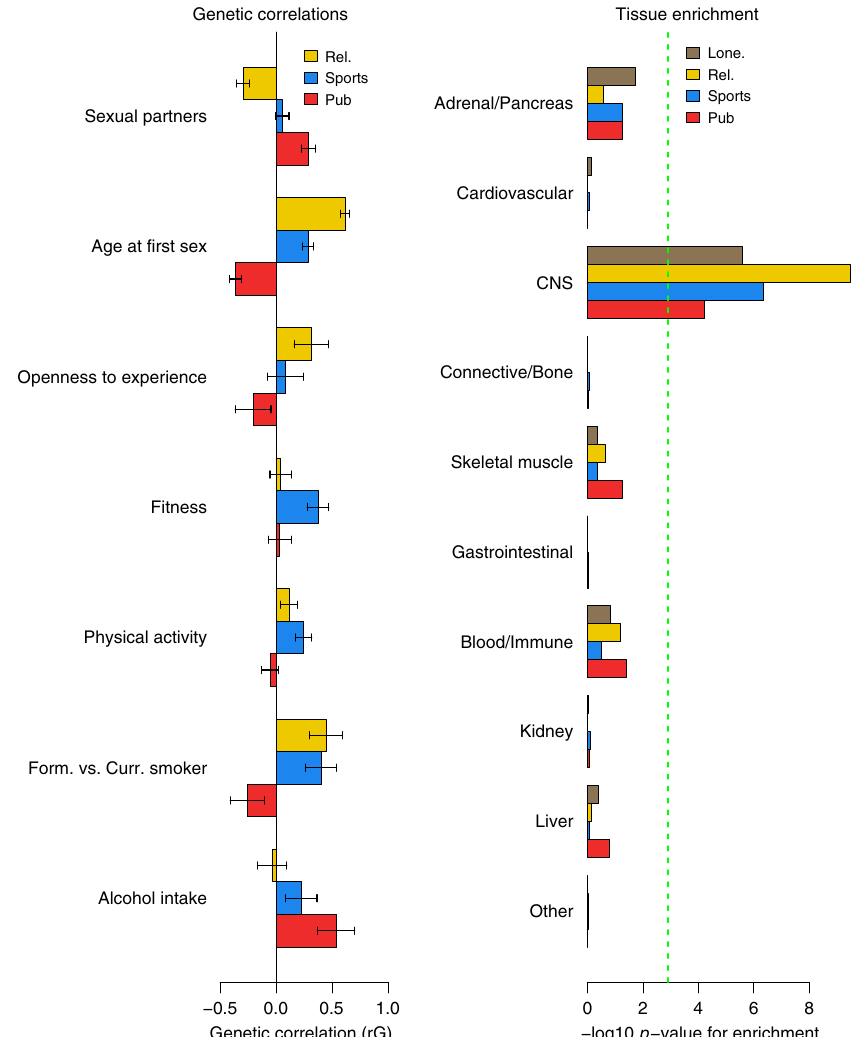
Fig. 2 Genetic correlations and tissue enrichment results. Left: Genome-wide genetic correlations between regular participation in three different social activities – religious group (yellow), sports club /gym (blue), pub/social club (red). Right: Gene expression enrichment across genome-wide association results for the four social isolation and interaction traits, the green dotted line indicates Bonferroni corrected statistical signi fi